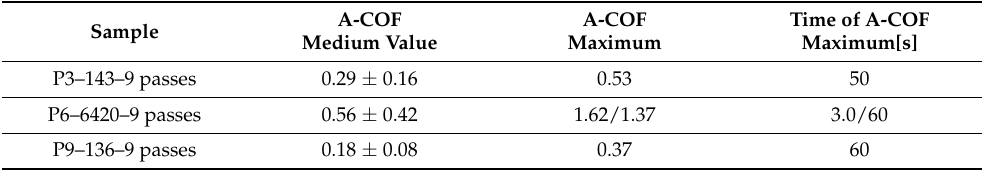
Table 5. Values of A-COF recorded by samples covered with ceramic layers.